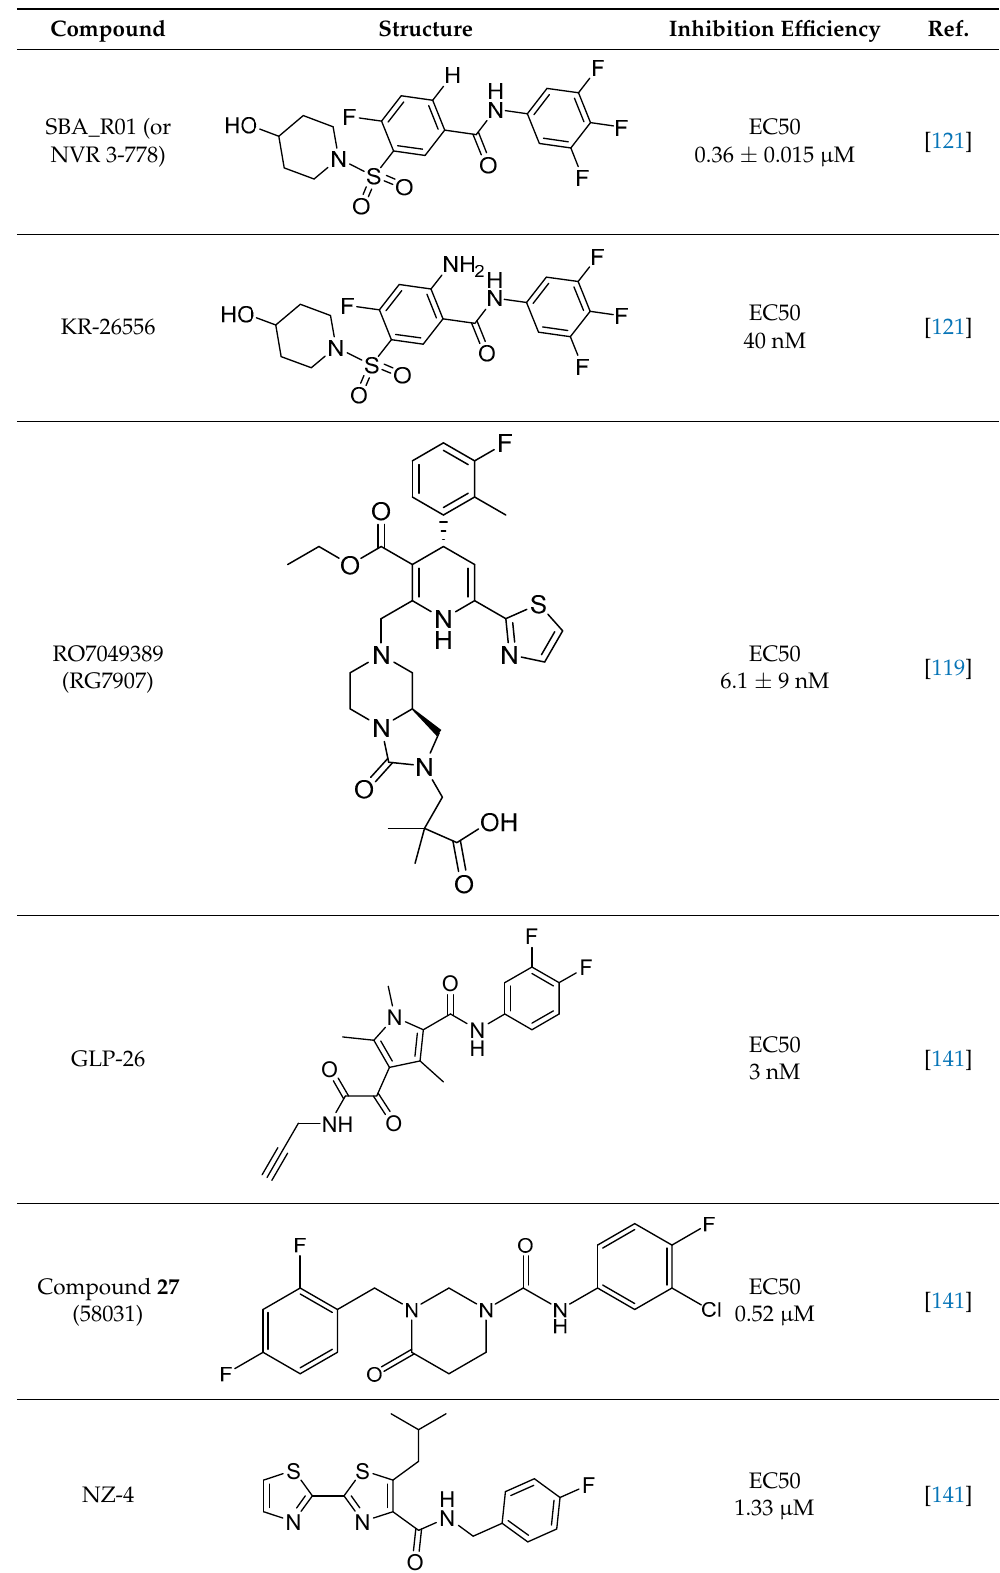
Table 2. Cont. Compound Structure Inhibition Efficiency